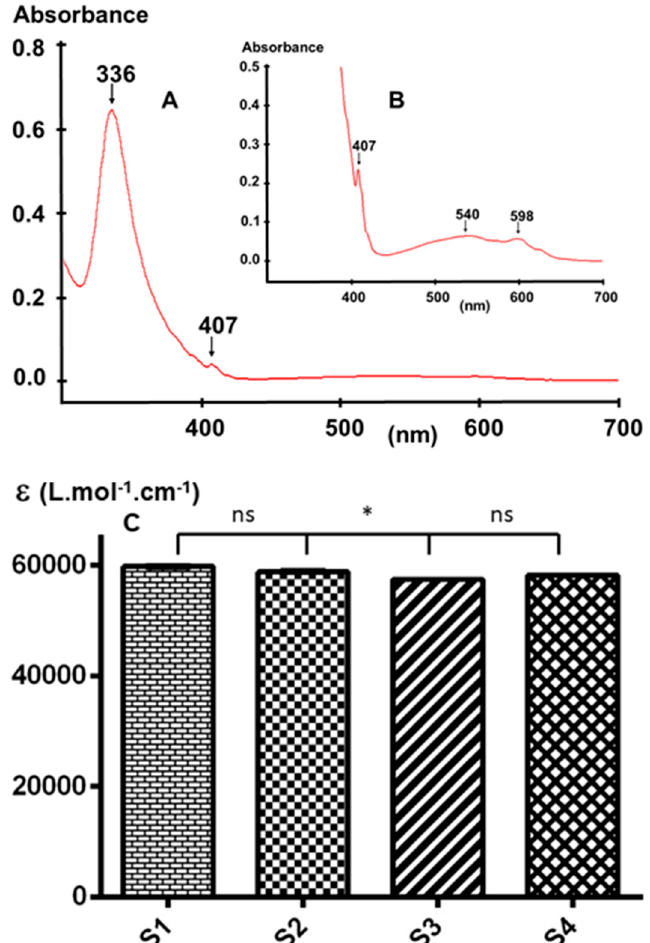
Figure 6. Representative UV-Visible spectrum of ( A ) a C 60 sample; ( B ) magnification of (A); and ( C ) comparison between the molar absorptivity of the four samples. (ns = not significant) .